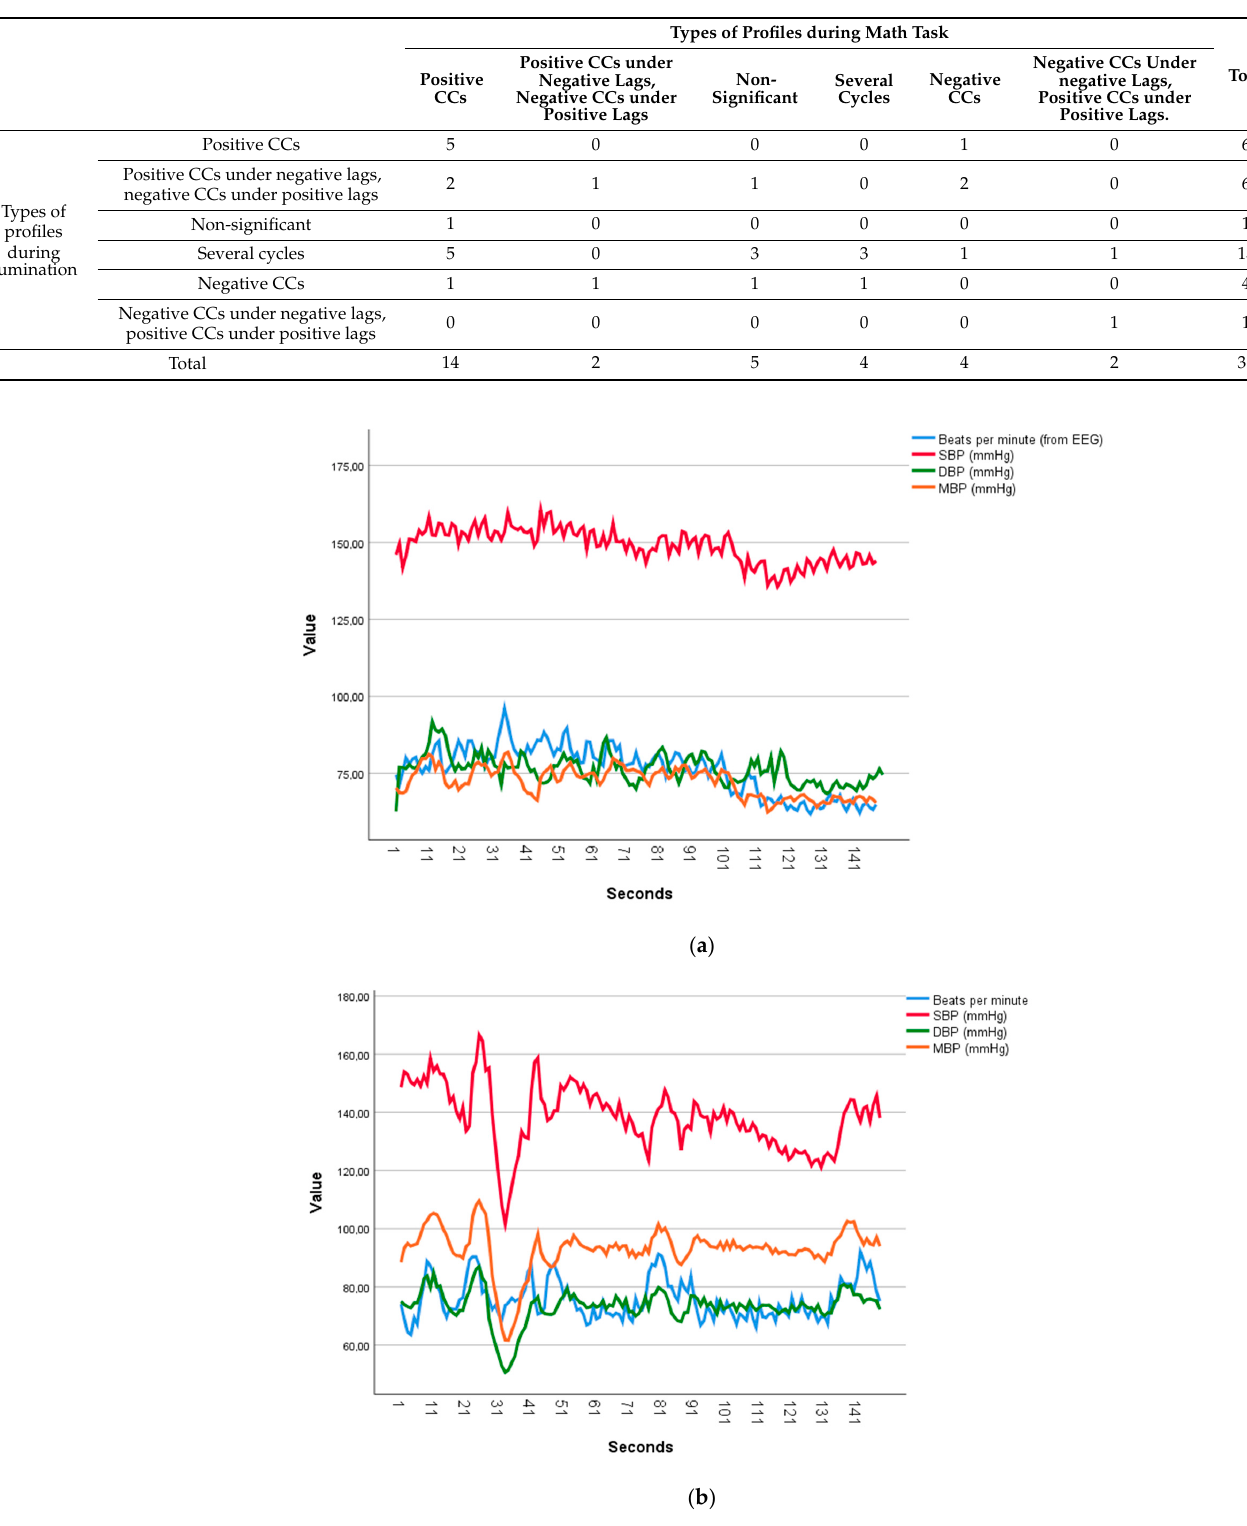
Table 2. Contingency tables among types of individual heart rate—systolic blood pressure cross- correlations (CCs) profiles during the math and rumination tasks. Number of cases.